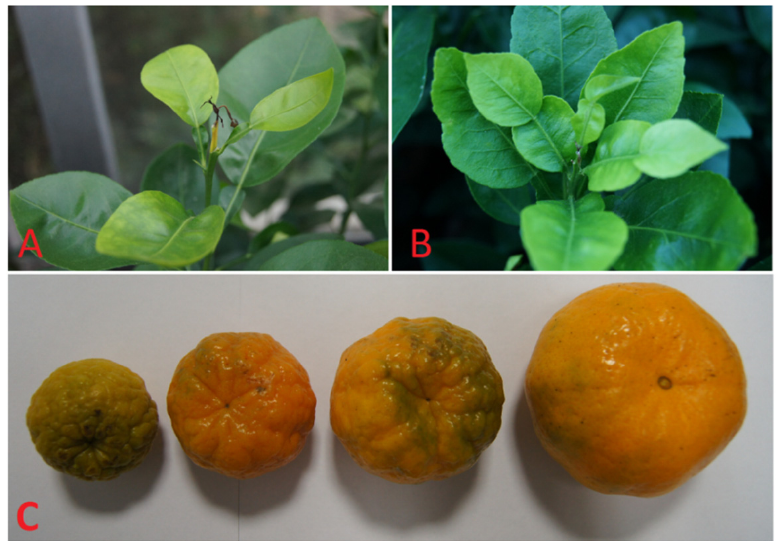
Figure 1. Symptoms of B deficiency in the leaves of C. sinensis ( A ) and C. grandis ( B ), and the fruits of “Ponkan” ( C. reticulata ) ( C ). Seedlings of C. sinensis ( A ) and C. grandis ( B ) were treated with 0 μ M H 3 BO 3 for 15 weeks, respectively. Fruits of “Ponkan” were collected from Citrus orchard in Yongchun county, Quanzhou, Fujian province, China ( C ).